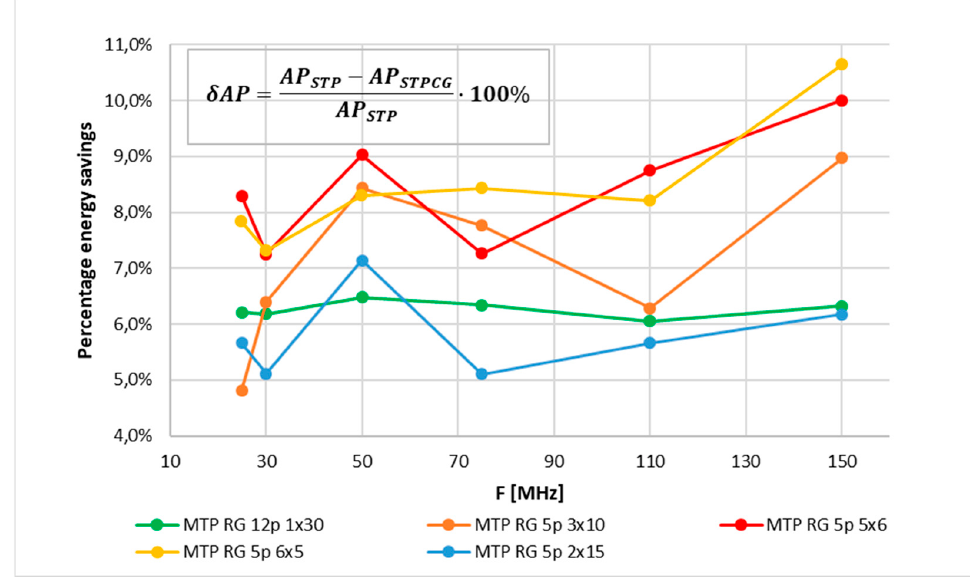
Figure 11. The average power savings per task for the architecture with a RAM gating mechanism compared with the appropriate MTP structure for different frequencies.